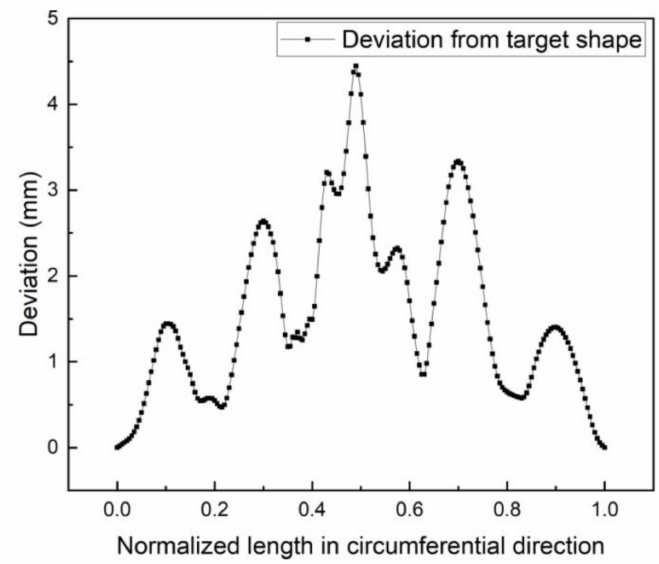
Figure 11. Deviation distributions along normalized length in circumferential